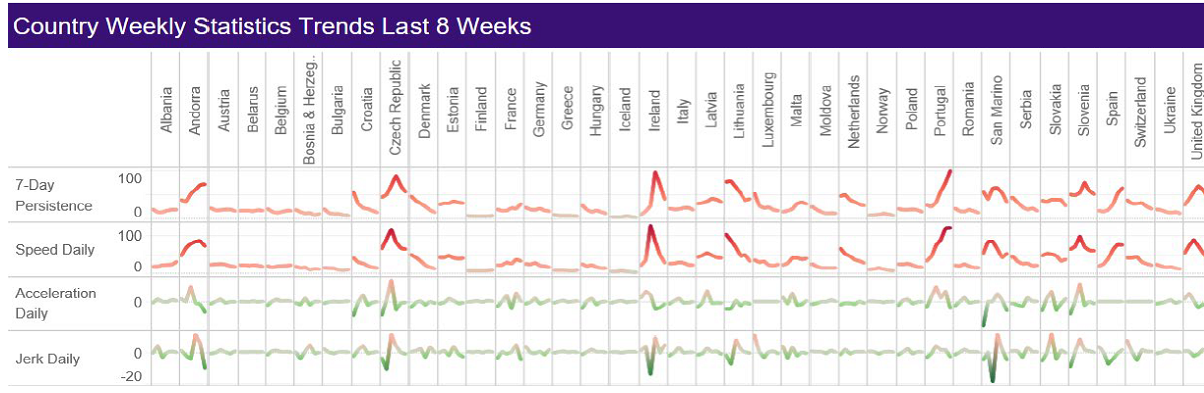
Figure 2. Weekly SARS-CoV-2 trends by country in Europe (December 7, 2020, to January 17, 2021; data source: [62]).